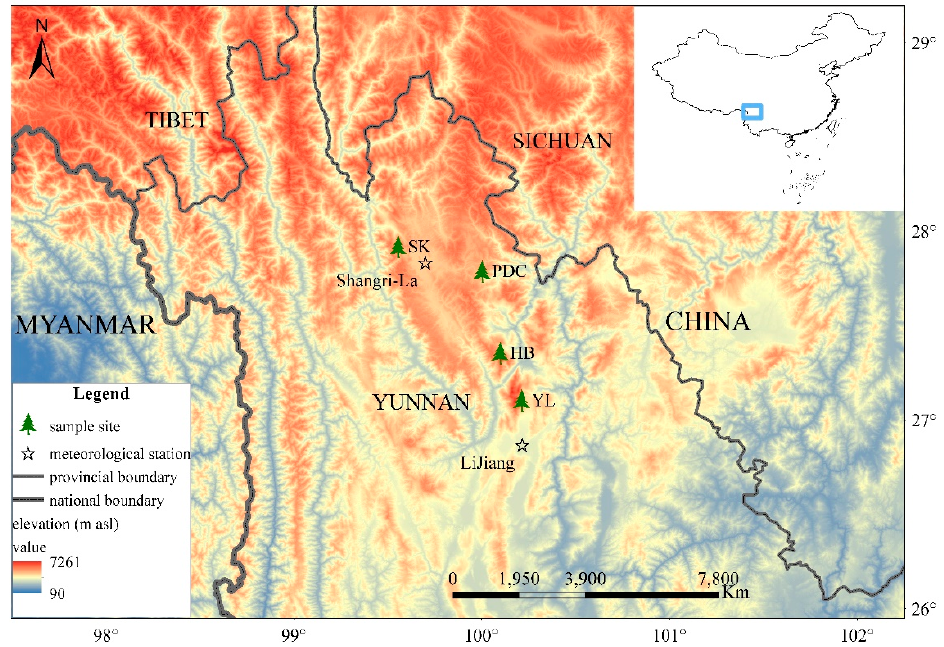
Figure 1. The location of sampling sites and meteorological stations. SK: Shika Snow Mountain; PDC: Potatso National Park; HB: Haba Snow Mountain; YL: Yulong Snow Mountain; the same below.